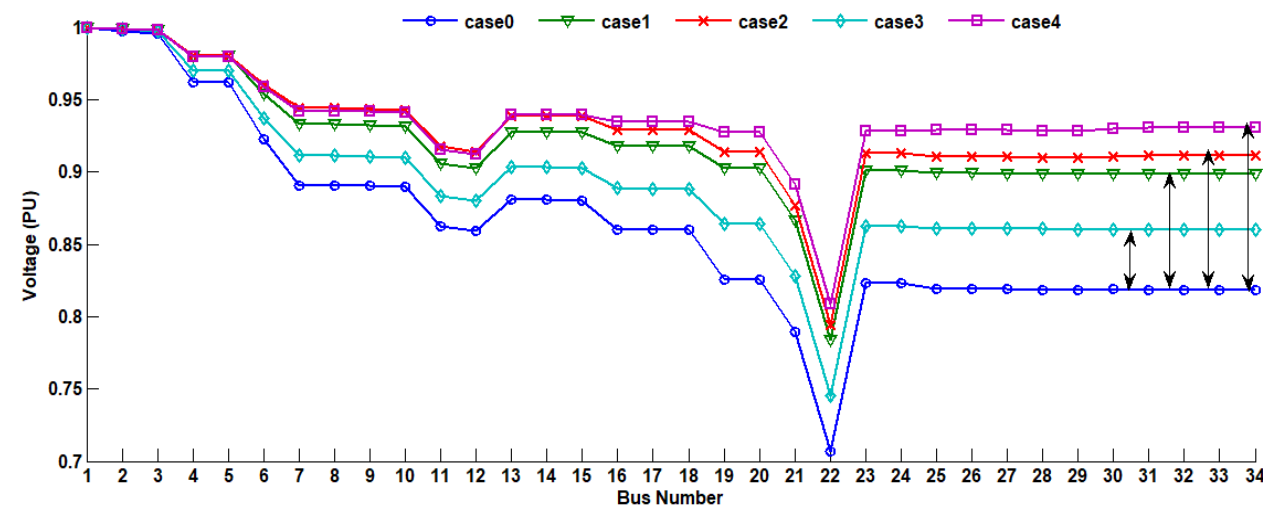
Figure 6. Voltage profiles of the second strategy.